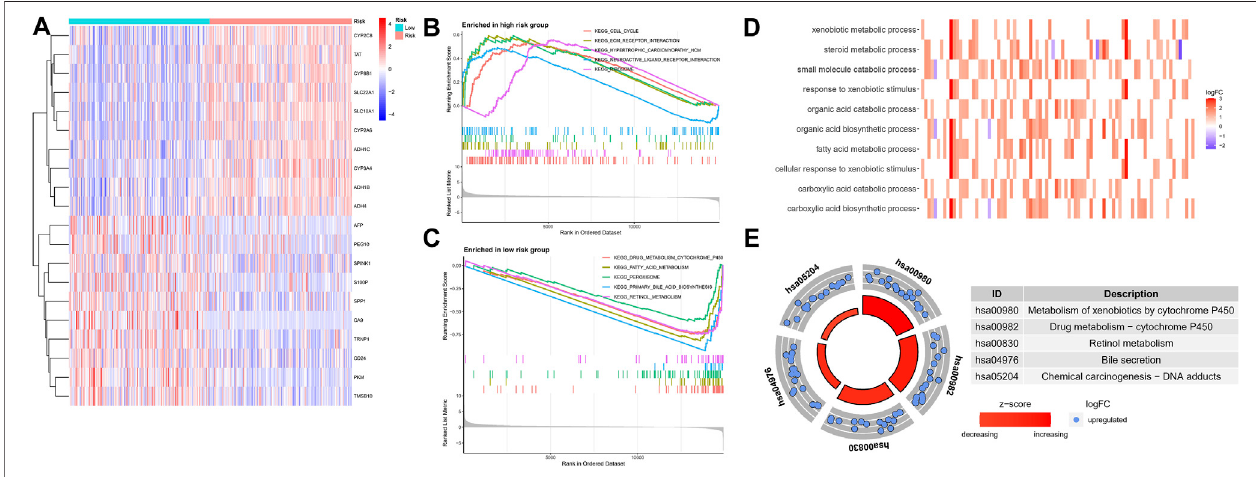
FIGURE 10 | Functional enrichment analysis in different risk groups. (A) The heatmap of differentially expressed genes. (B,C) GSEA of the top 5 pathways signi fi cantly enriched in both high (B) and low-risk groups (C) . (D,E) GO and KEGG enrichment analysis of differentially expressed genes.